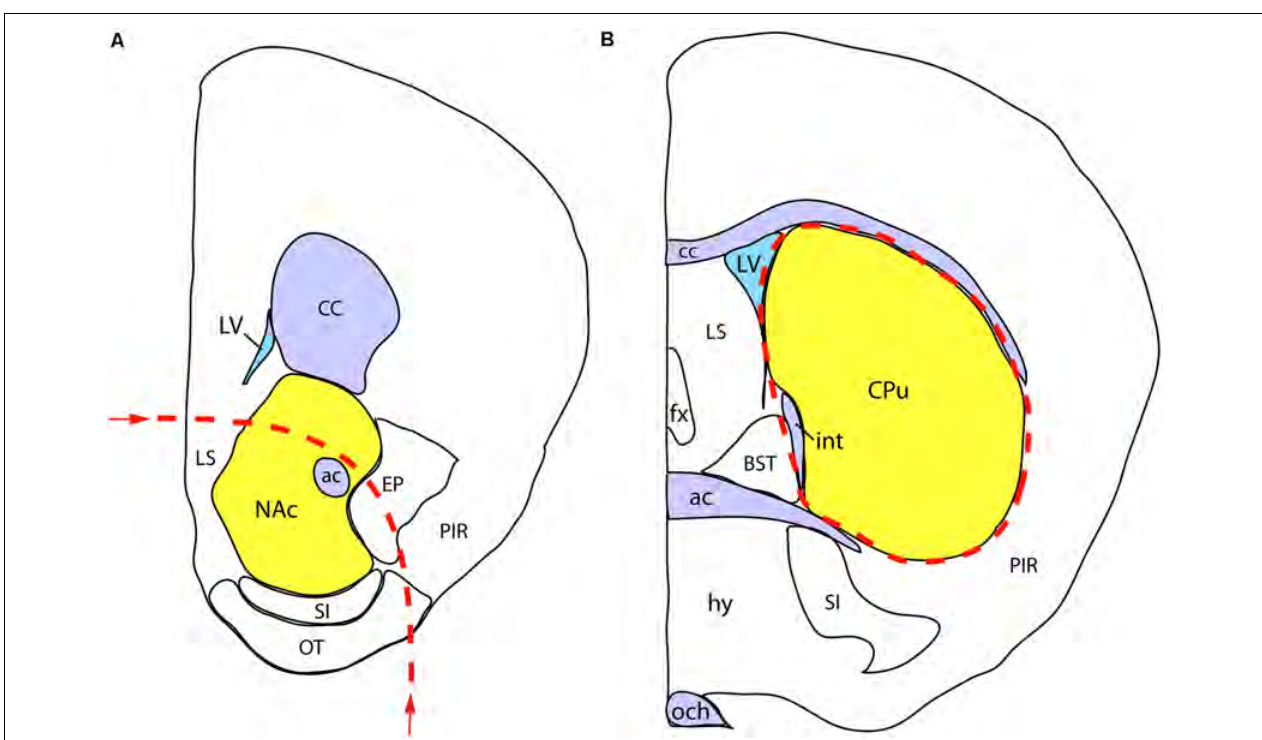
FIGURE 3 | Schematic demonstration of mouse brain samples freshly dissected for dopamine assay. (A) The rostral face of the tissue slab 1 with the approximate borders of dissection (dashed line). The sample to be removed is centered on the nucleus accumbens (NAc), also including parts of the lateral septum (LS), endopiriform nucleus (EP), substantia innominata (SI), olfactory tubercle (OT), and the nucleus of the diagonal band (NDB; not visible at this plane of section). (B) The rostral face of the tissue slab 2. The dissected sample (marked by a dashed line) is centered on the caudate-putamen (CPu), also including part of the globus pallidus, external segment (not visible at this level). Other abbreviations: ac, anterior commissure, BST, bed nucleus of stria terminalis, CC, corpus callosum; fx, fornix; hy, hypothalamus; int, internal capsule; LV, lateral ventricle; och, optic chiasm; PIR, piriform cortex.